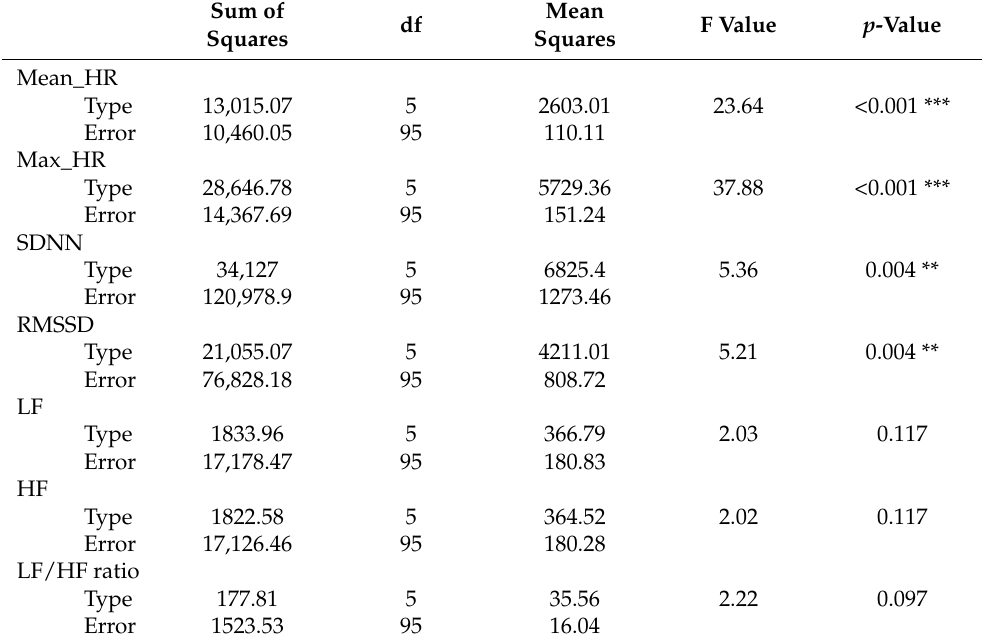
Table 2. Repeated measure ANOVA on ECG